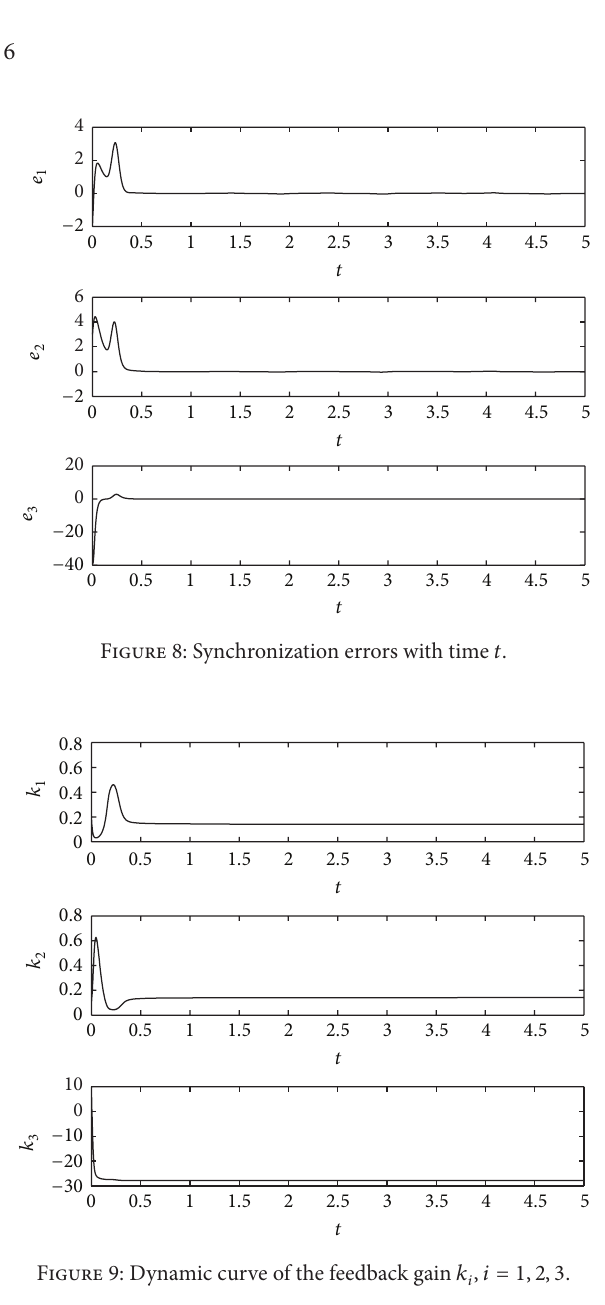
Figure 9: Dynamic curve of the feedback gain 𝑘 𝑖 , 𝑖 = 1, 2,3